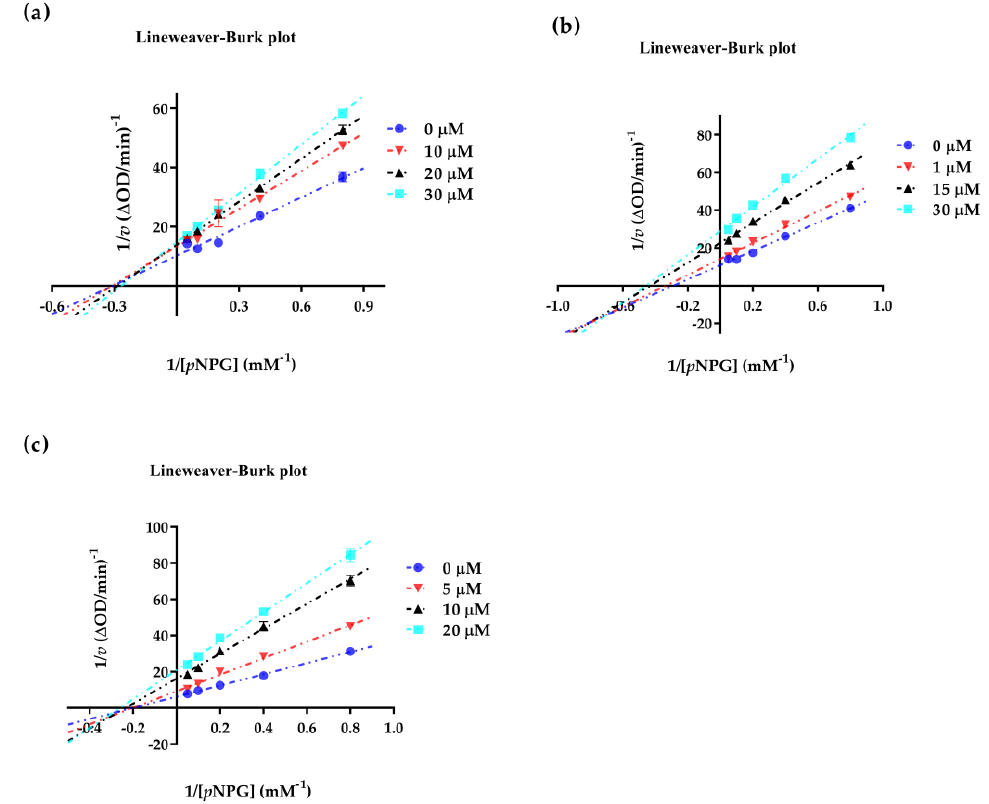
Figure 7. The Lineweaver–Burk plot for α -glucosidase inhibition of compounds 3 , 9 , and 13 . ( a ) 1/[ p NPG] − 1/ v fitting curve of compound 3 . ( b ) 1/[ p NPG] − 1/ v fitting curve of compound 9 . ( c ) 1/[ p NPG] − 1/ v fitting curve of compound 13 . All values are mean ± SD from at least three independent experiments.